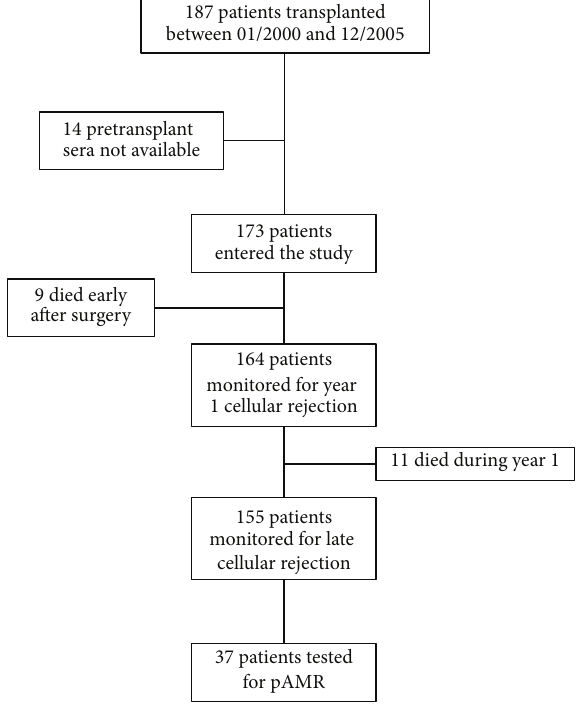
Figure 1: Study flow